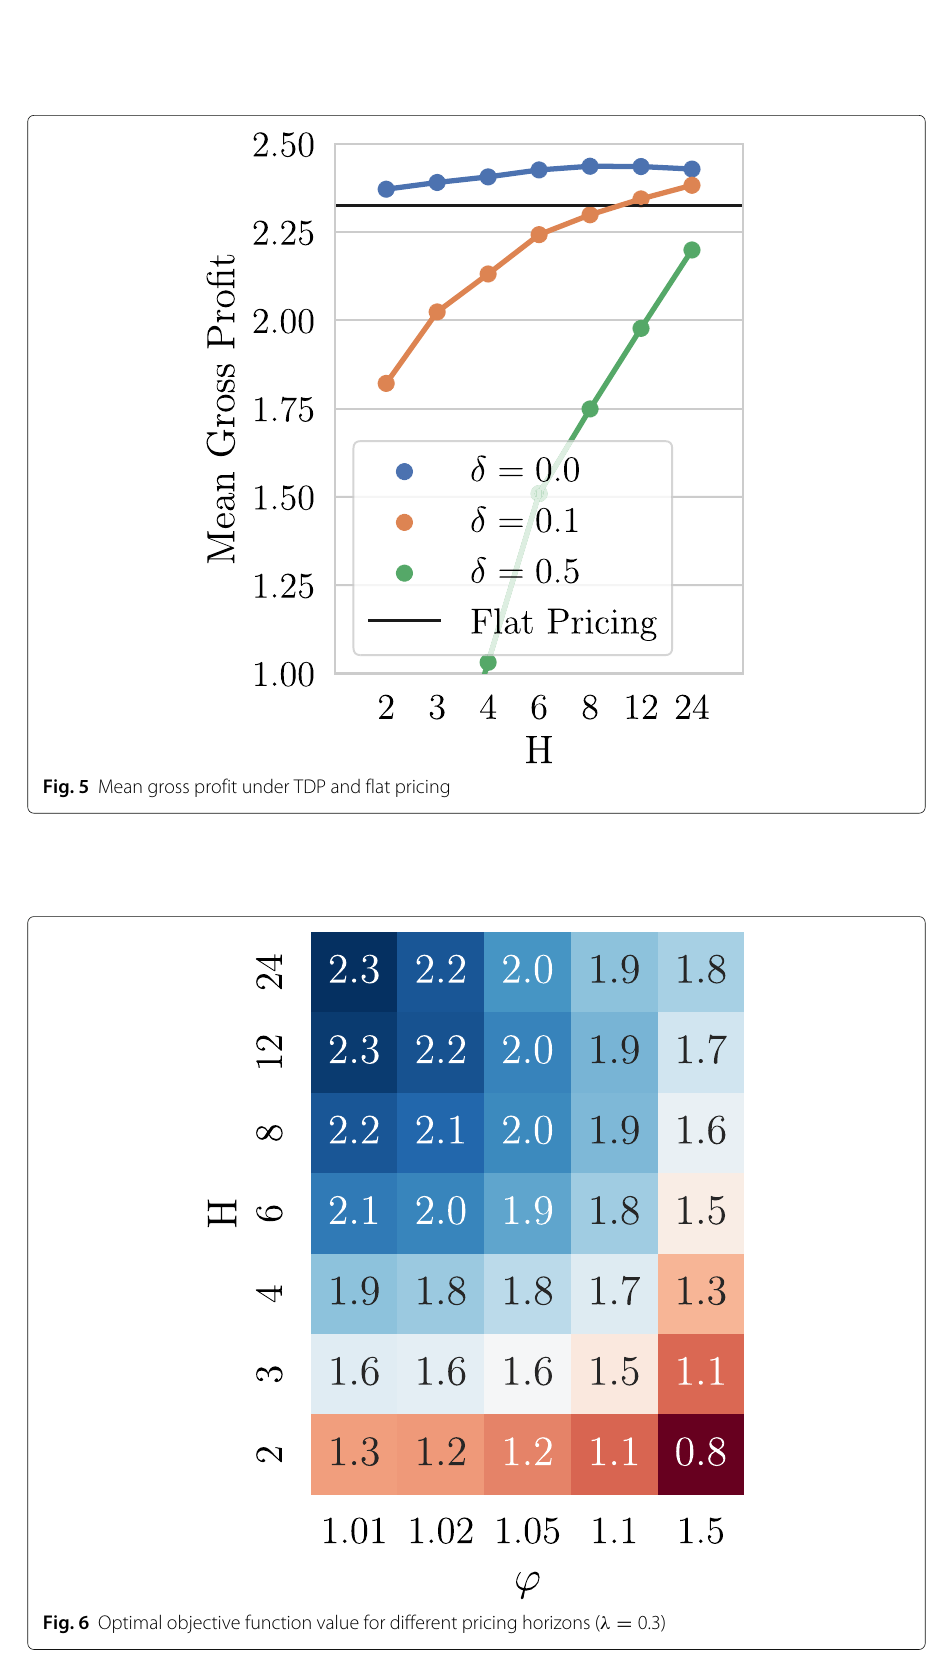
Fig. 6 Optimal objective function value for different pricing horizons ( λ =